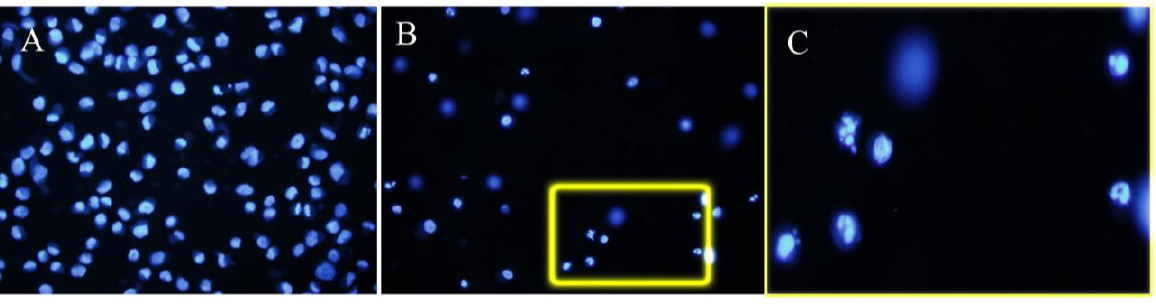
Figure 3. Culture of COLO 858 melanoma cells not treated (A) or treated with the NK-1 receptor antagonist L-732,138 (B). (C) High power magnification of the region delimited by the yellow rectangle in B. Note the apoptotic figures. Chromatin condensation and nuclear fragmentation are